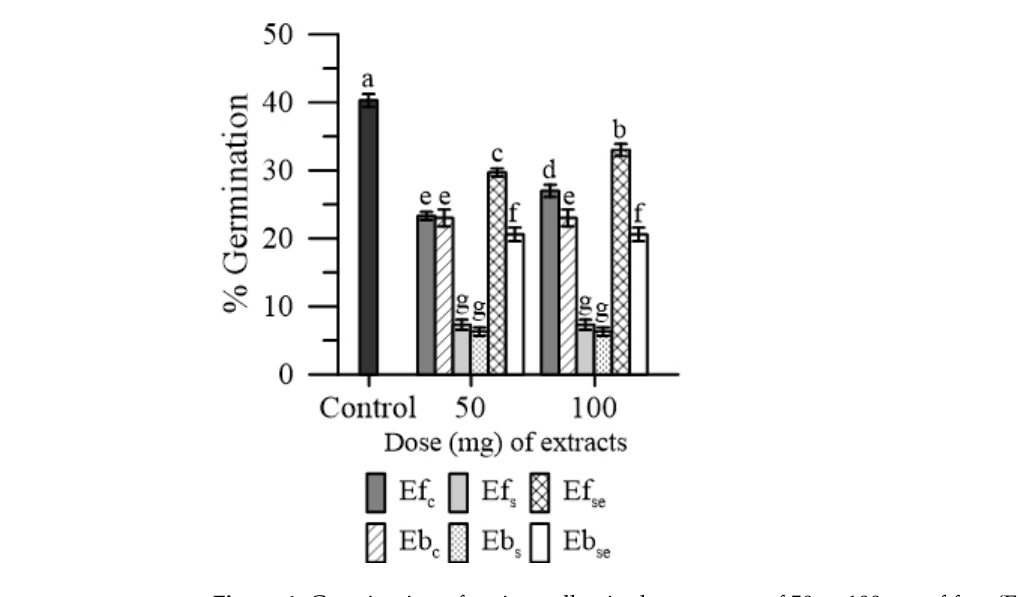
Figure 4. Germination of maize pollen in the presence of 50 or 100 mg of free (Ef) and bound (Eb) extracts of emmer wheatgrass grown with distilled water as a control (Ef c , Eb c ), or in the presence of salinity as NaCl 50 mM (Ef s , Eb s ) or selenium as 45 mg L − 1 of Na 2 SeO 3 (Ef Se , Eb Se ). Data are expressed as means ± SEM from five independent tests. Different letters indicate significant differences for p < 0.05.